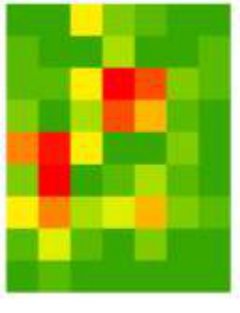
Figure 4. Simple test case – visualized. Color range from green (low values) to red (high values)